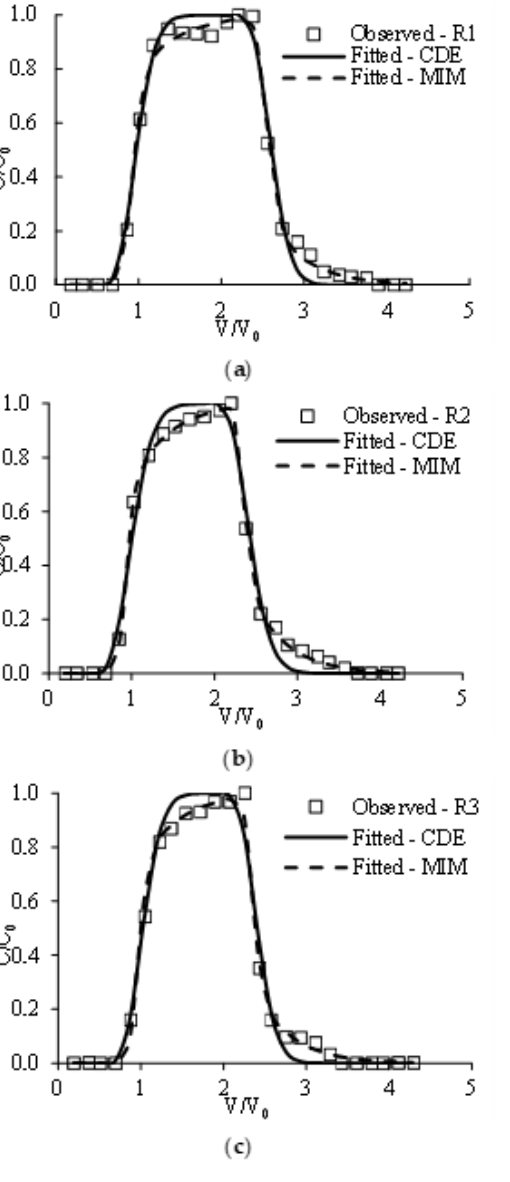
Table 6. Estimated parameters, determination coefficient R 2 , and statistical criteria for the two-re- gion model for CM1 and CM2 for the tracer (KBr).